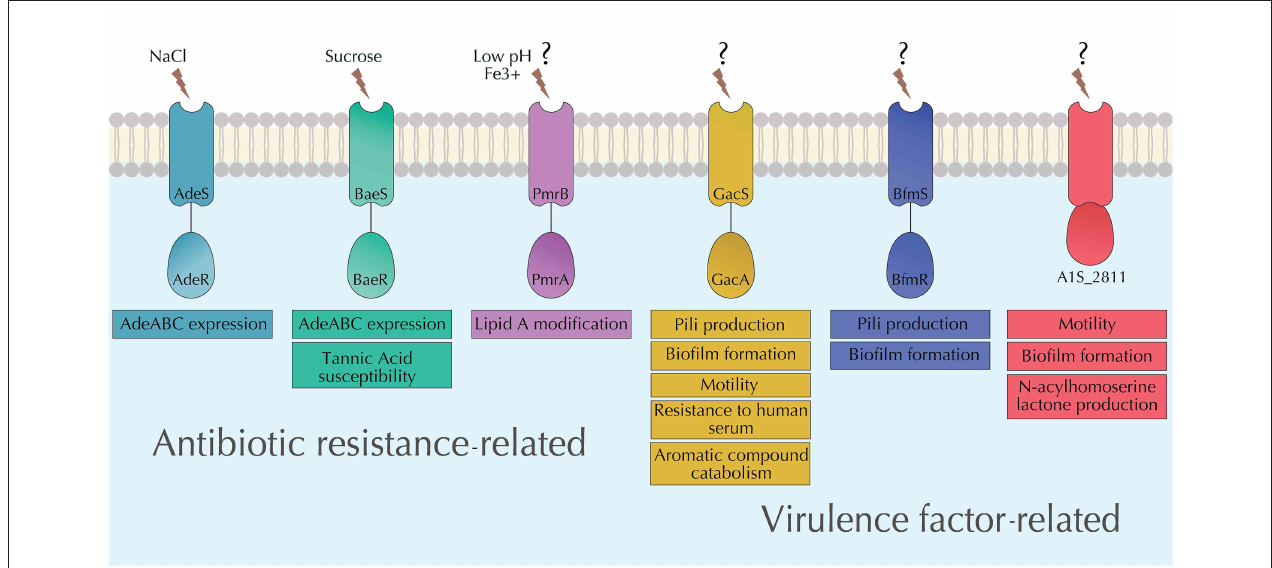
FIGURE 3 | Summary of the characterized TCSs in A. baumannii . Functions of each of the characterized TCSs in A. baumannii (AdeRS, BaeSR, PmrAB, GacSA, BfmRS, and A1S_2811) as well as their known stimuli are